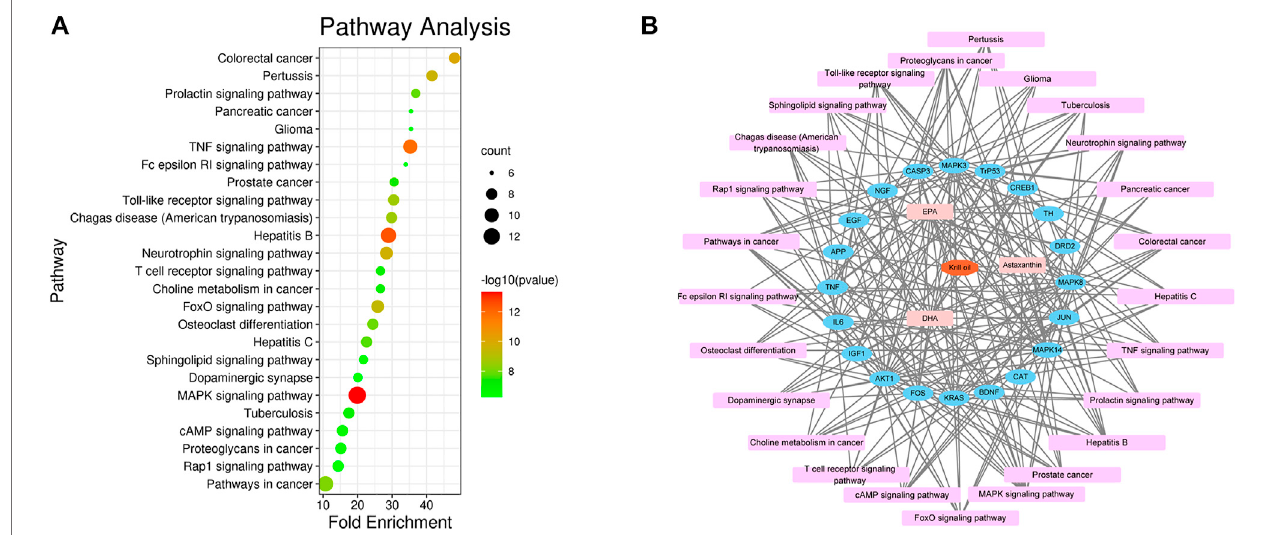
FIGURE 6 | Pathway enrichment and network analyses of hub genes. (A) The top 25 signi fi cantly enriched pathways of hub genes. (B) The compound – target – pathway network for krill oil on METH-induced memory de fi cits. The orange polygon represented krill oil. The pink squares represented active compounds of krill oil and the blue circle represented potential hub genes. The mauve squares represented pathways. The edges represent the interactions between them.